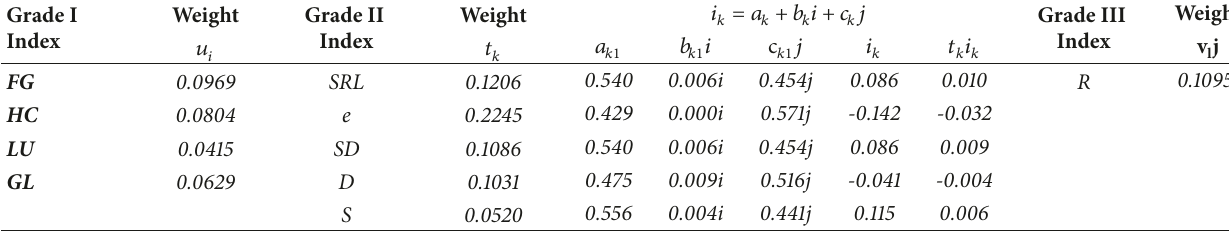
Table 14: Results of connection degree 𝜇(𝐴, 𝐵 1 ) A